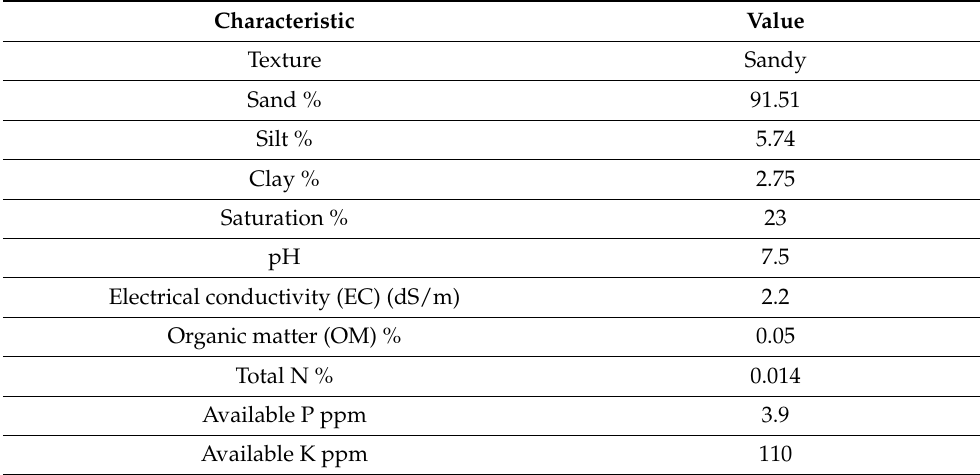
Table 2. Physical and chemical properties of the experimental soil.